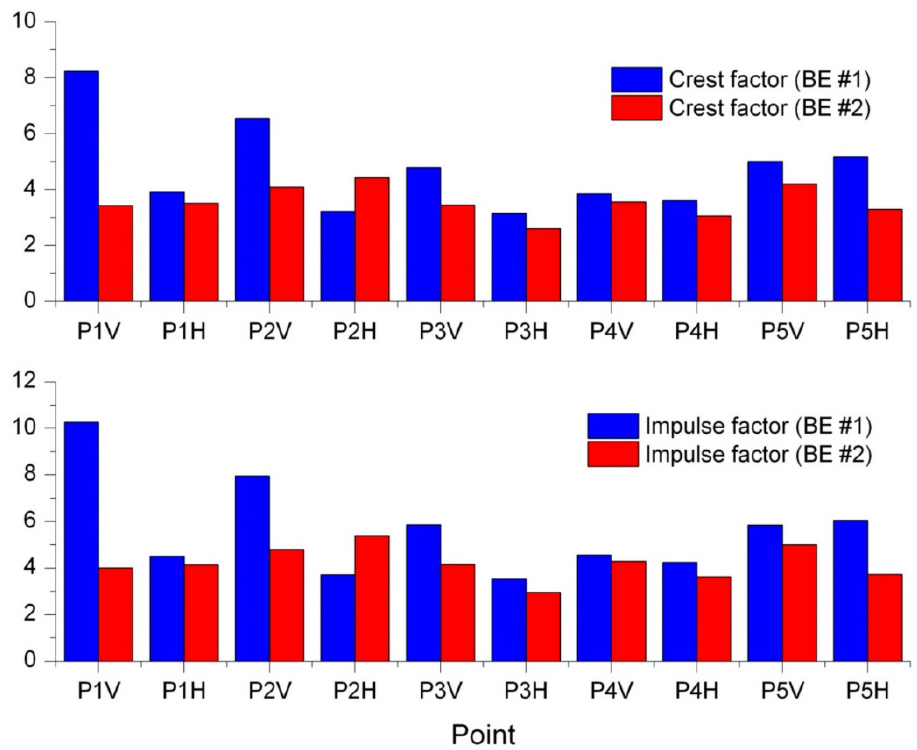
Figure 7. Crest factor and Impulse factor of vibration velocity in the drive units of the tested bucket elevators BE#1 and BE#2.